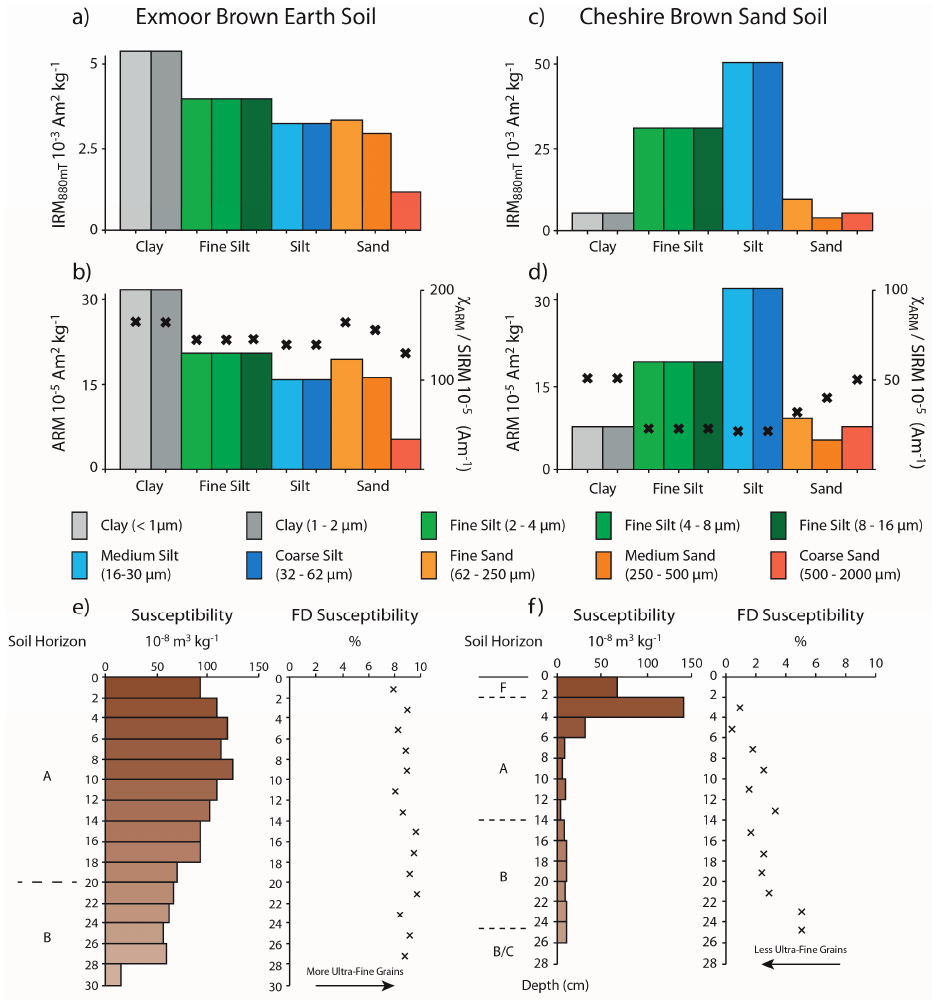
Figure 3. IRM, ARM, and χ ARM /SIRM as a function of physical grain size for a Brown Earth (Cambisol) soil ( a , b ) and a Brown Sand Soil ( c , d ). Also shown are bulk MS and bulk frequency dependence of susceptibility with depth for the two soil profiles ( e , f ). Figure redrawn from Maher [3]. Note the χ ARM /SIRM scale changes between profiles. The Exmoor Brown Earth soil has a relatively high percentage of ultra-fine pedogenic SP grains throughout the profile concentrated in the clay size fraction. In contrast, the brown sand soil carries its relatively coarse magnetic grains in the silt fraction and is restricted to the upper few centimeters of the profile resulting from atmospheric fall out of MD size ferrimagnetic pollution